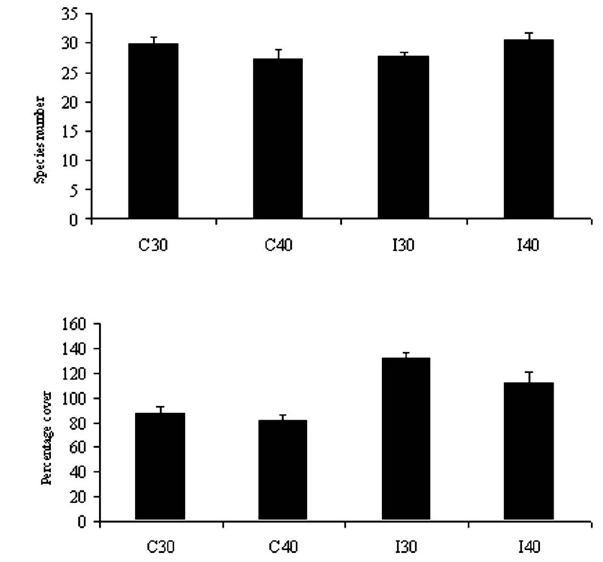
Fig . 4. – Species number per sample and total percentage cover of marcoalgal coralligenous assemblages (encrusting Corallinales excluded). C, continental coast; I, small islands; numbers indicate sampling